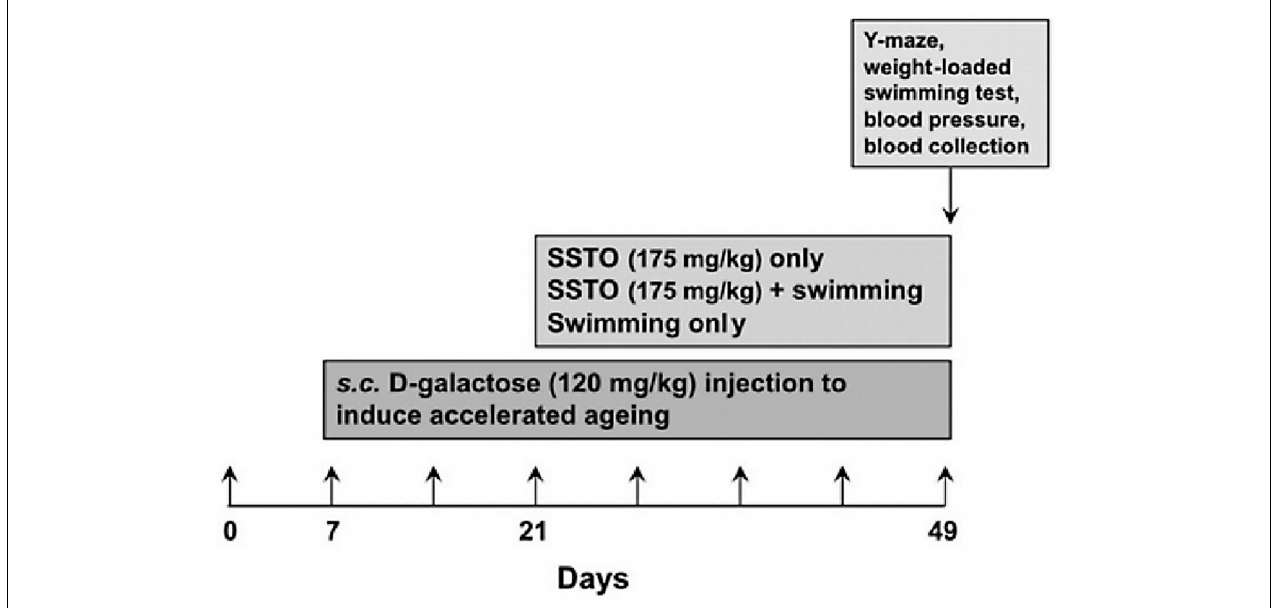
FIGURE 1 | Flowchart of the animal experiment. One week after the animals had been allowed to adapt to the environment, the rats were injected subcutaneously with D -galactose to induce accelerated aging for 42 days. SSTO feeding and/or swimming training were started on day 14 after the D -galactose injections began and continued for 4 weeks. The outcomes were assessed using the Y-maze for learning memory performance and weight-loaded swimming for physical fitness testing. Blood pressure was also recorded and blood samples were collected for further